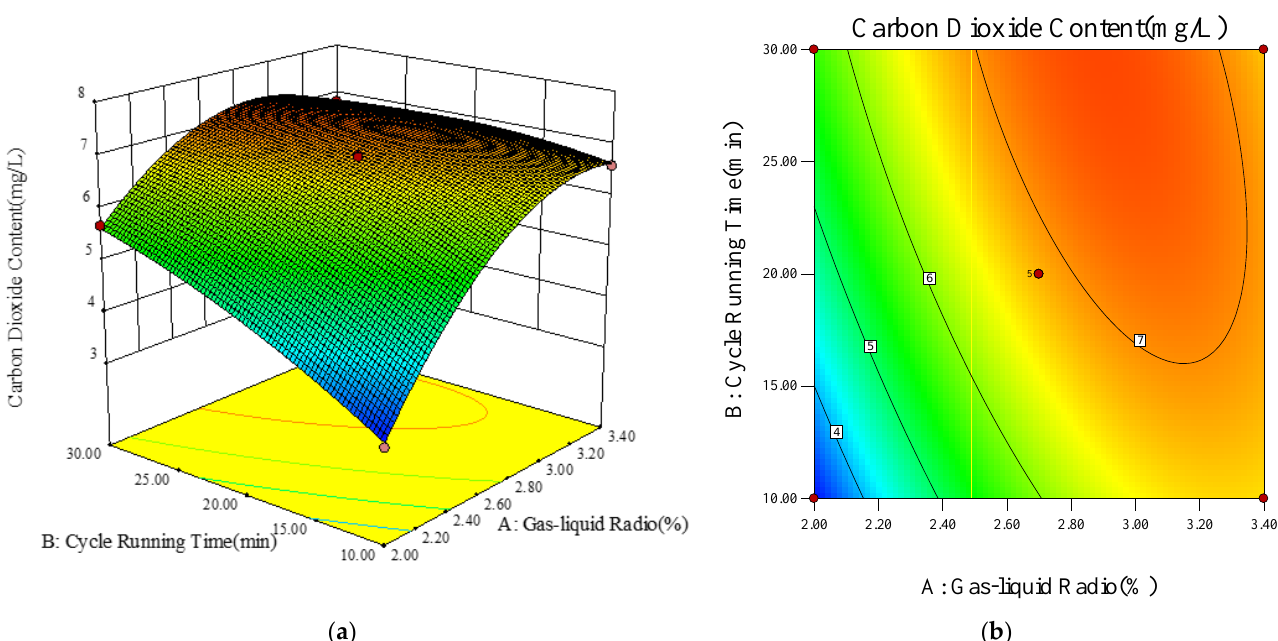
Figure 6. The interaction between the gas – liquid ratio and the generator running time: ( a ) response surface and ( b ) contour lines.